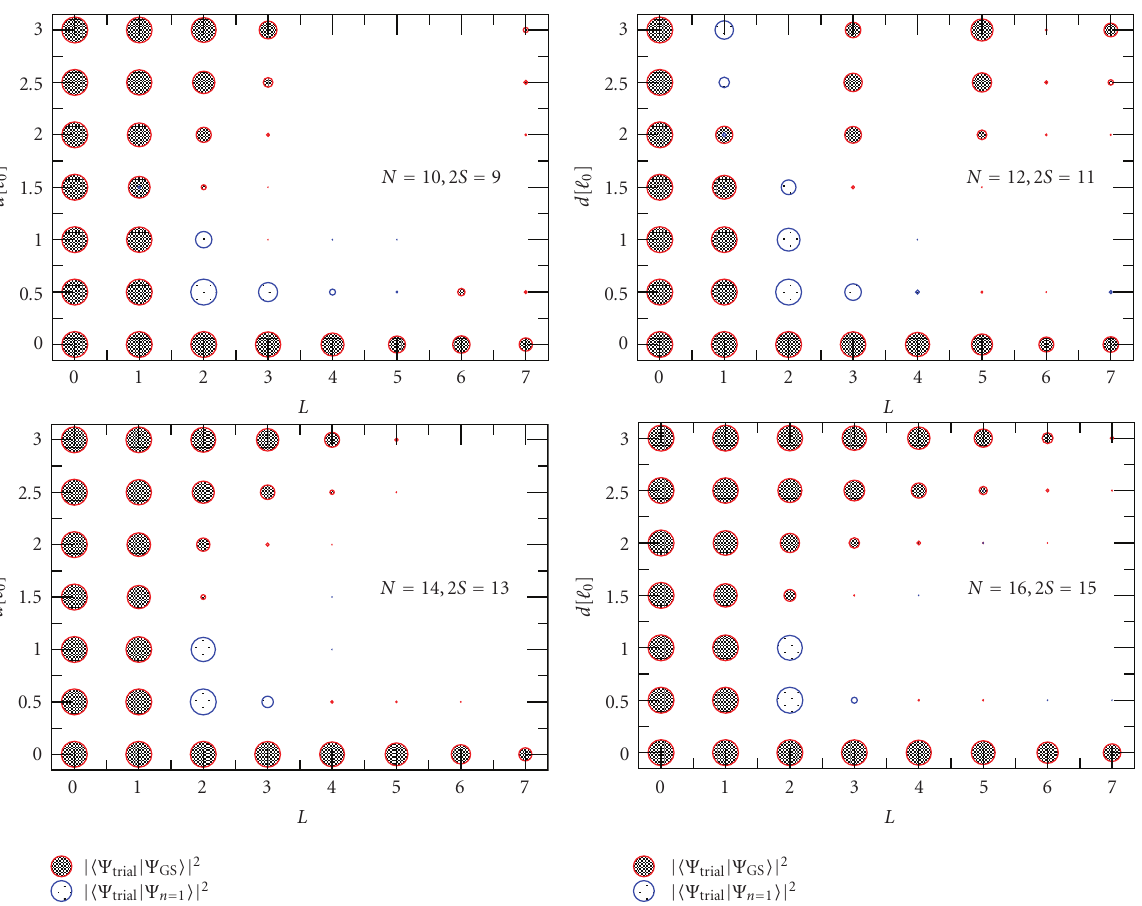
Figure 1: Overlaps of the trial states (3) with the exact eigenstates of the Coulomb Hamiltonian for a selection of system sizes N = 10, 12, 14, and 16 on the sphere. The magnitude of the overlap of the trial state with the exact ground state is indicated by the size of red dark shaded circles. Blue lightly shaded circles additionally indicate the overlap of the same trial states with the first excited state of the exact spectrum. Overlaps at L = 0 are equal to one by definition and give the overall scale. The trial states are very accurate at d = 0, giving a good description of the lowest energy mode in each sector of angular momentum (the Goldstone mode) up to large L . At finite layer separation d , the Goldstone mode is always present at small L but does not reach to similarly high values of angular momentum. The description is again more successful at very large d